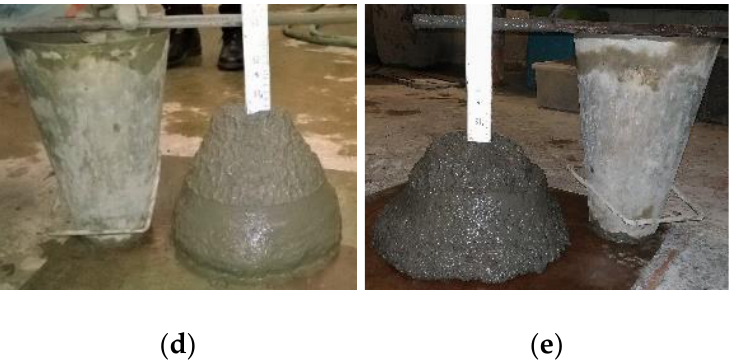
Figure 10. Images of representative specimens during slump test of REF and EAFS mixtures: ( a ) REF1 mixture with a slump class S3; ( b ) REF2 mixture with a slump class S4; ( c ) EAFS mixture with a slump class S1; ( d ) EAFS mixture with a slump class S2/S3; ( e ) EAFS mixture with a slump class S4.